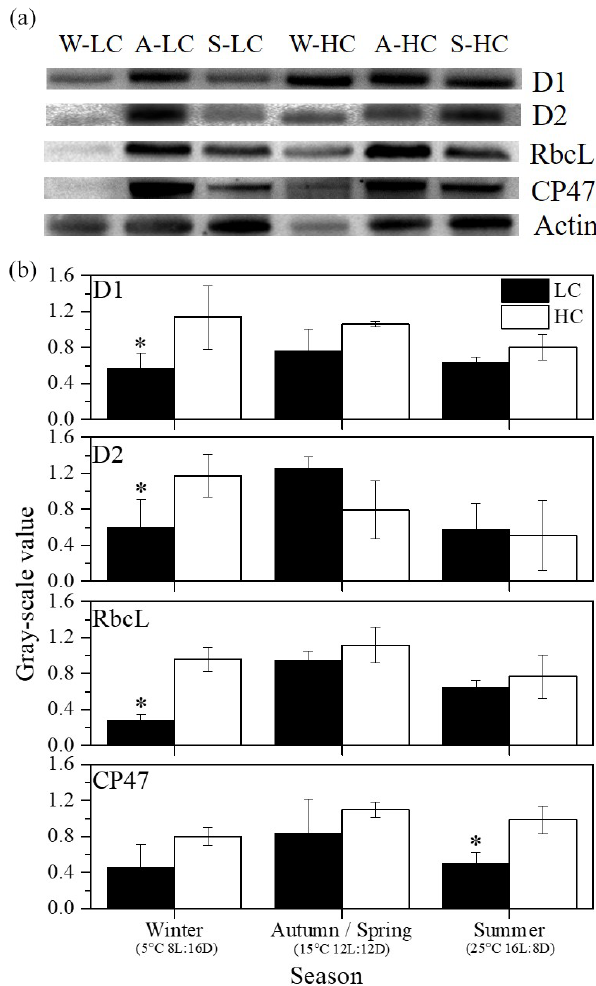
Figure 5. (a) Immunoblot using antibodies against RbcL and key PSII proteins (PsbA (D1), PsbD (D2) and PsbB (CP47)) isolated from S. costatum acclimated to ambient and elevated p CO 2 in dif- ferent season levels (W for winter, A for autumn, S for summer). Each line was loaded with similar amounts of proteins. (b) Quanti- tative analysis of proteins. The relative abundance of each band was estimated by densitometric scanning of the exposed films. Aster- isks represent significant differences ( P < 0 . 05) between two CO 2 levels under same season ( t